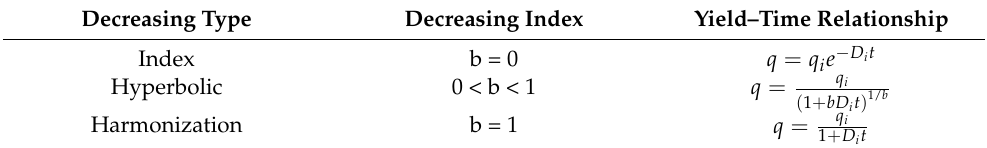
Table 6. Three decreasing yield